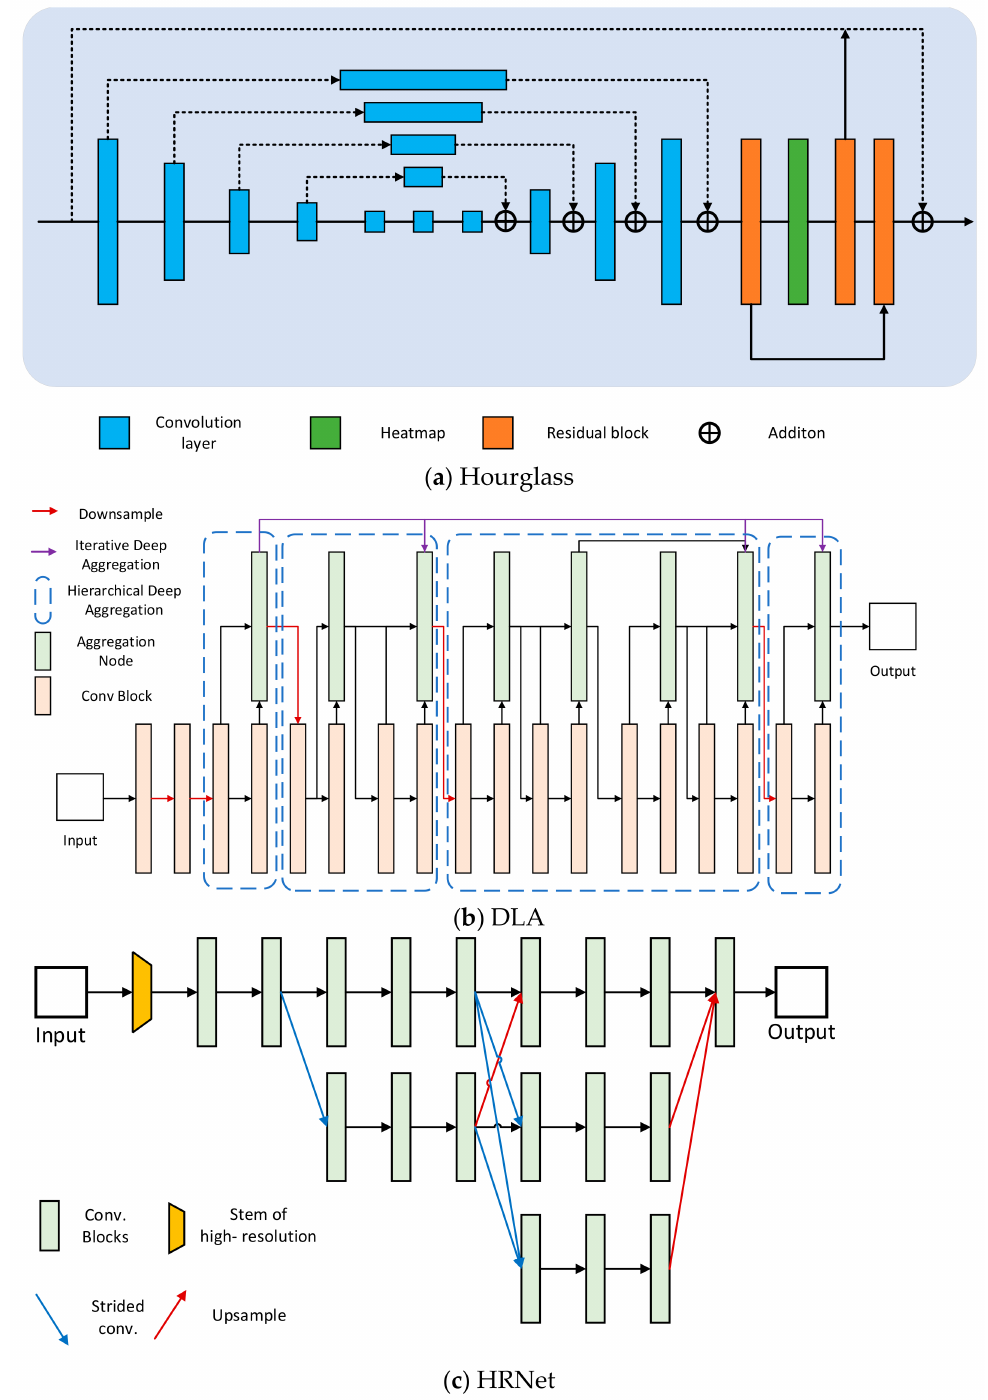
Figure 2. Structures of three state-of-the-art backbone networks for human pose estimation. DLA: DLA [25] is an image classification network with hierarchical skip connections, in which aggregation is defined as the combination of different layers throughout a network. DLA uses iterative deep aggregation to symmetrically increase feature map resolution, preventing loss of information in dense predictions. Moreover, DLA hierarchically merges features to create networks with better accuracy and fewer parameters. The structure of a DLA network is illustrated in Figure